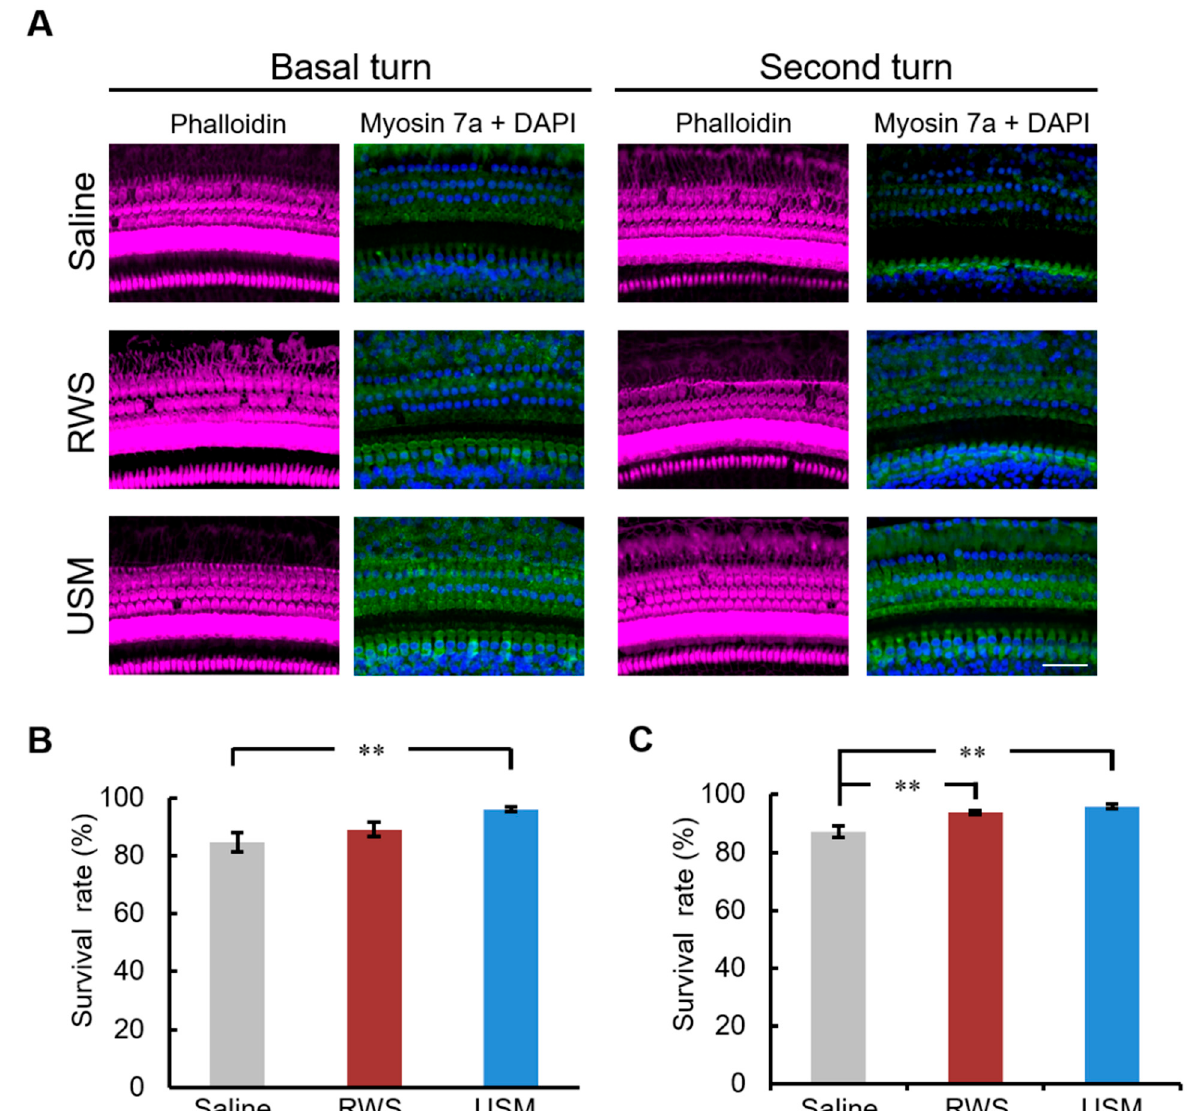
Figure 3. IGF-1 delivery aided by ultrasound microbubbles enhances the preservation of cochlear hair cells following noise exposure. ( A ) Representative images of a surface preparation of the basal and second turns of the cochlea from the three groups on day 28 after noise exposure. Immunofluorescence staining showing cell bodies of hair cells (green, myosin 7a), nuclei (blue, DAPI) and filamentous actin (magenta, phalloidin). This experiments were repeated six times. Scale bars = 50 µm. The survival rates of the outer hair cells in the basal turn ( B ) and second turn ( C ) in guinea pigs from each experimental group. The results are expressed as the mean ± SEM; n = 6 for each bar; ** p < 0.01. IGF-1, insulin-like growth factor-1; DAPI = 4,6-diamidino-2-phenylindole; USM, ultrasound microbubble; RWS, round window soaking.